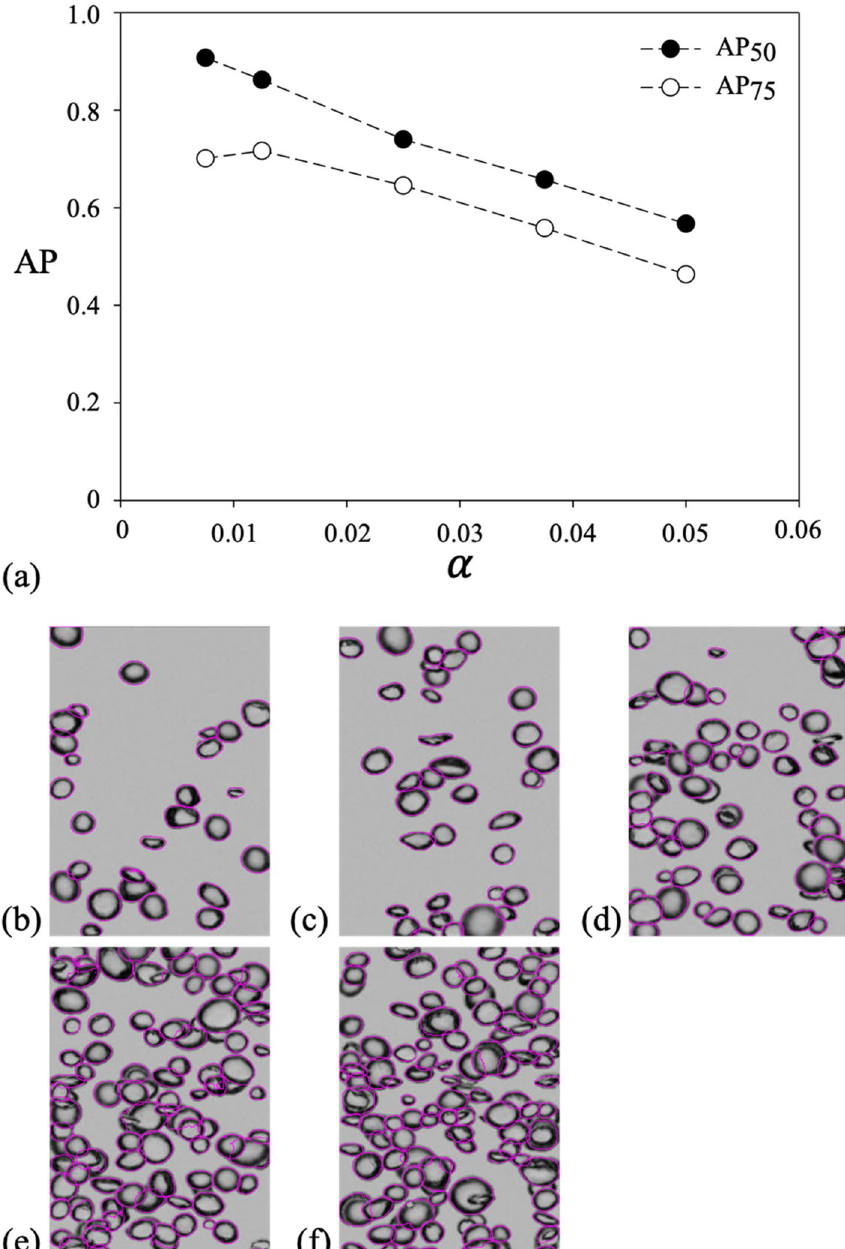
Figure 4. ( a ) Variation of AP 50 and AP 75 of synthetic images with volume void fraction (α). Representative bubble images with detection results (purple solid lines) are shown for α of ( b ) 0.0075; ( c ) 0.0125; ( d ) 0.0250; ( e ) 0.0375; ( f )